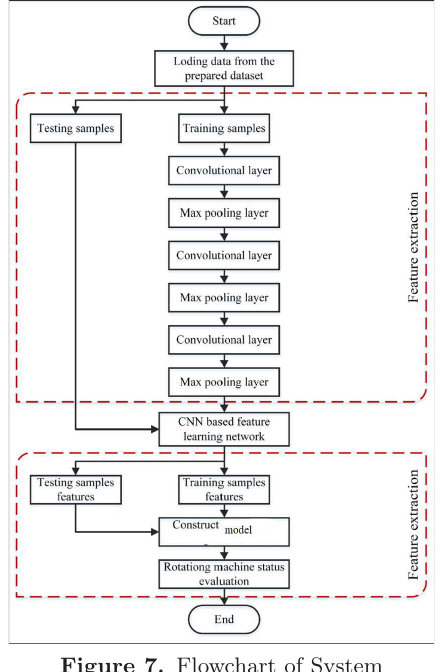
Figure 7. Flowchart of